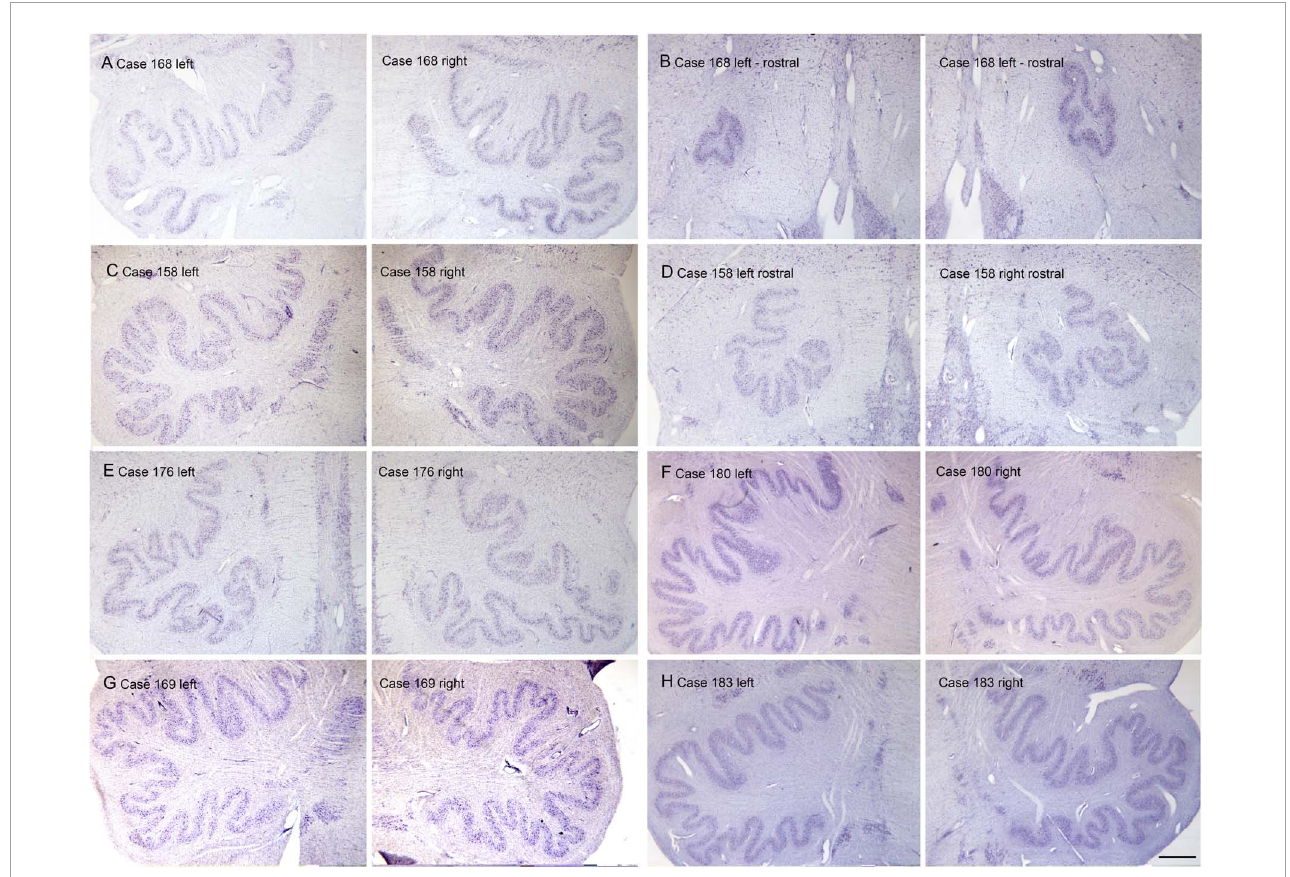
FIGURE5 Individual variability and left-right asymmetry in the principal nucleus of the inferior olive (IOpr) in the human. Each panel (A–H) shows a pair of images from the left and right sides of the brain. For two cases 168 (A,B) and 158 (C,D) there are two panels showing pairs of sections at two different rostro-caudal levels. (E) Case 176. (F) Case 180. (G) Case 169. (H) Case 183. The asymmetry is present at all levels. Scale bar = 1 mm (all